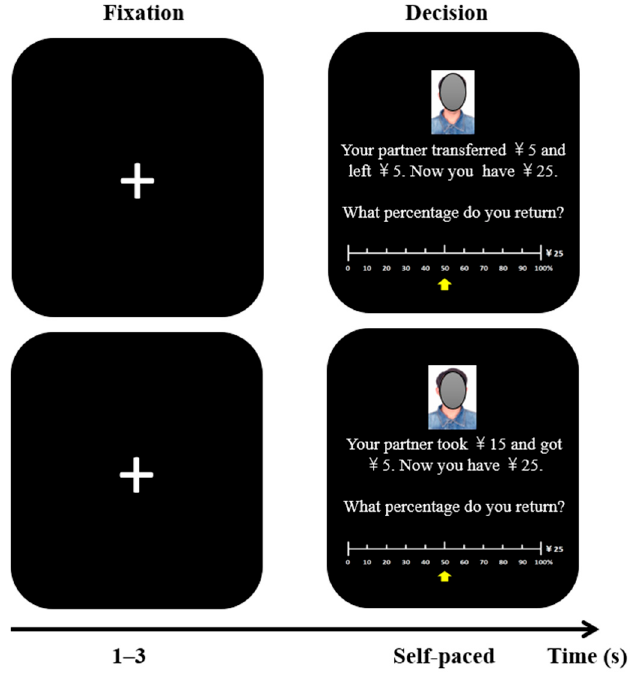
Figure 7. Example reciprocity trial for TG ( upper ) and DTG ( lower ). After a Fixation was shown (1 – 3 s), the Decision screen showed the face of the partner, the amount sent over (TG) or taken away (DTG) by the trustor, the amount that the participant held, and the response scale. Participants were required to choose which percentage (0–100% in 10% increments) to return to the trustor by moving the arrow with the left or right arrow key. They locked their choices by pressing the enter key. Participants made their ratings at their own pace. Note. The texts in the original picture are in Chinese. They are translated into English for communication